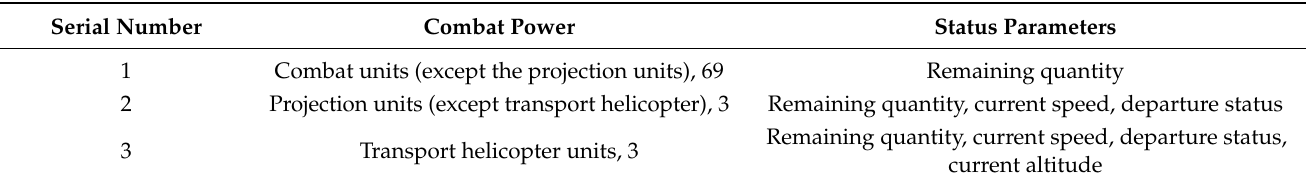
Table 1. State space tab in each time step1 state space in one time step.